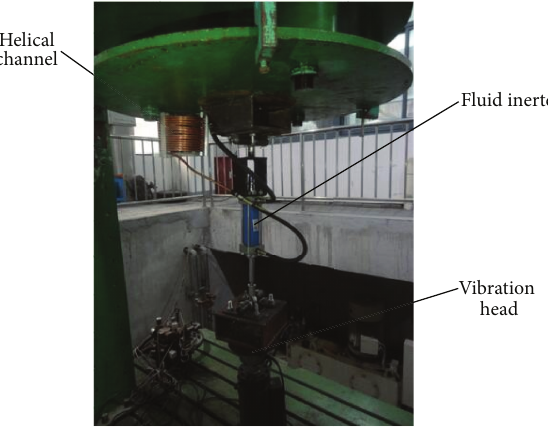
Figure 3: Bench test.